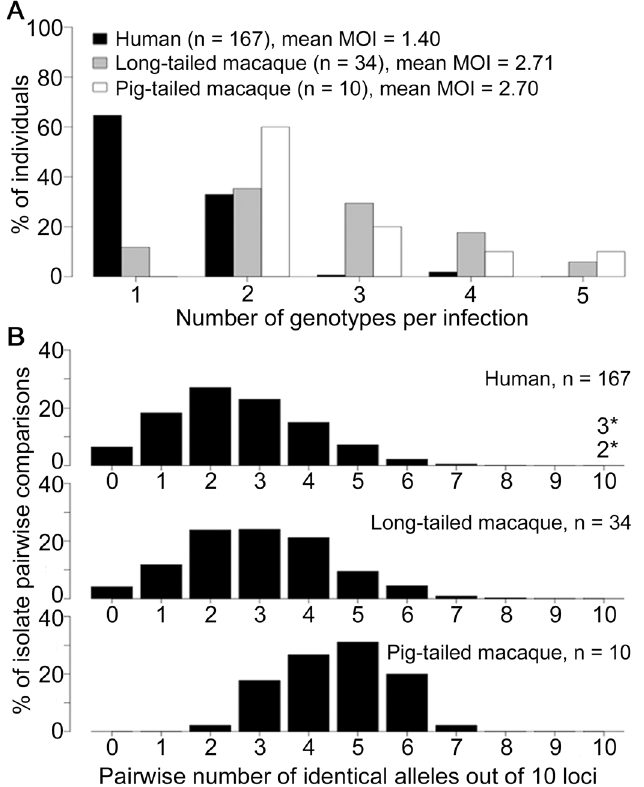
Fig 2. Multiple genotype P . knowlesi infections and diversity among infections in three host species from Kapit. All data for the multiple genotype infections and distribution of identical alleles between infections derived from complete genotyping of 10 microsatellite loci. (A) Numbers of different P . knowlesi genotypes per infection (multiplicity of infection, MOI) showing significant difference between human and macaque infections (Fisher ’ s Exact P < 1 x 10 – 15 ), but not between long-tailed and pig-tailed macaques (Fisher ’ s Exact P = 0.65). (B) Numbers of identical alleles out of 10 loci in pairwise comparisons of infections, showing a similar diversity among infections in humans and long-tailed macaques, but a higher average identity among